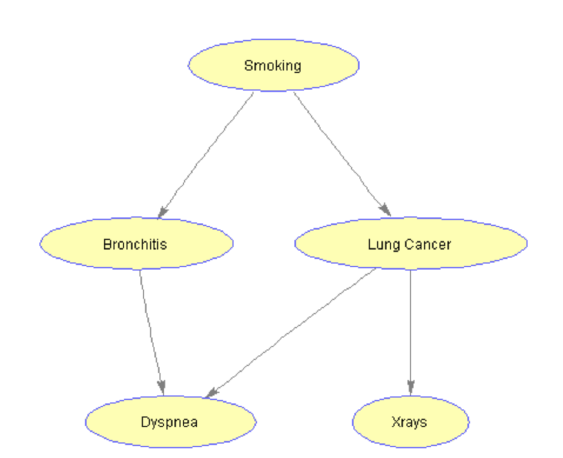
Figure 1. A Bayesian network example - Cancer